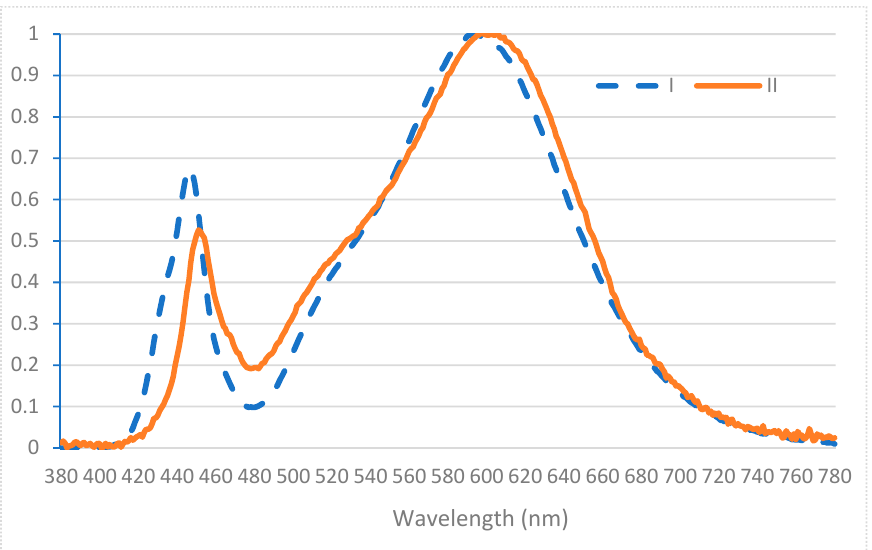
Figure 3. Normalised SPD for lighting applications I and II. Relative power is depicted on the y-axis and wavelength on the x-axis.